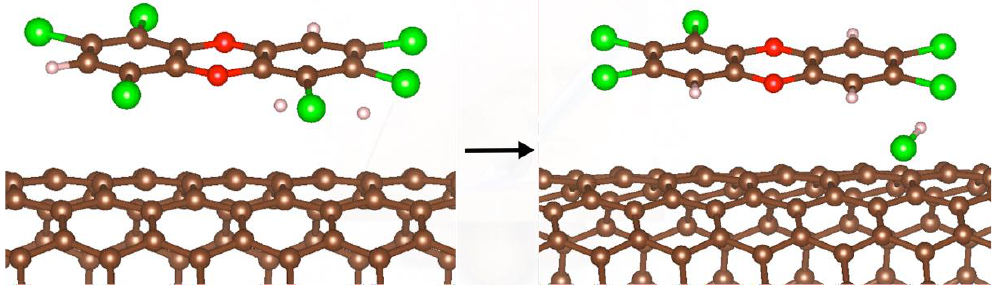
Figure 6. Hydrodechlorination of a HxCDD obtaining a PCDD and a HCl molecule. The brown spheres represent C atoms, the green spheres represent Cl atoms and white spheres are H atoms. Table 2. Energies for the adsorption and reactions modeled on the SWCN model, including the final distance between the dehydrogenated product PCDD and a HCl molecule.